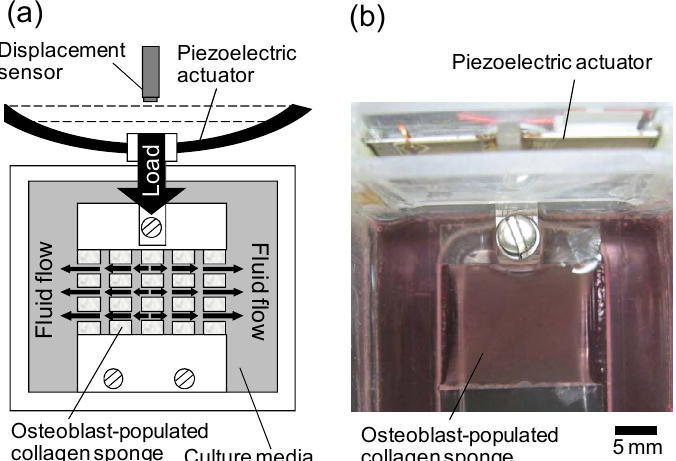
Figure 1 Schematic representation of the mechanical stimulator. A bimorph-piezoelectric actuator gives compressive loads to a construct placed in the culture chamber that is filled with the culture media. Osteoblasts in the collagen sponge are mechanically stimulated by matrix strain and fluid flow of the media. It is noted that the flow runs three-dimensionally along pore walls in the sponge.